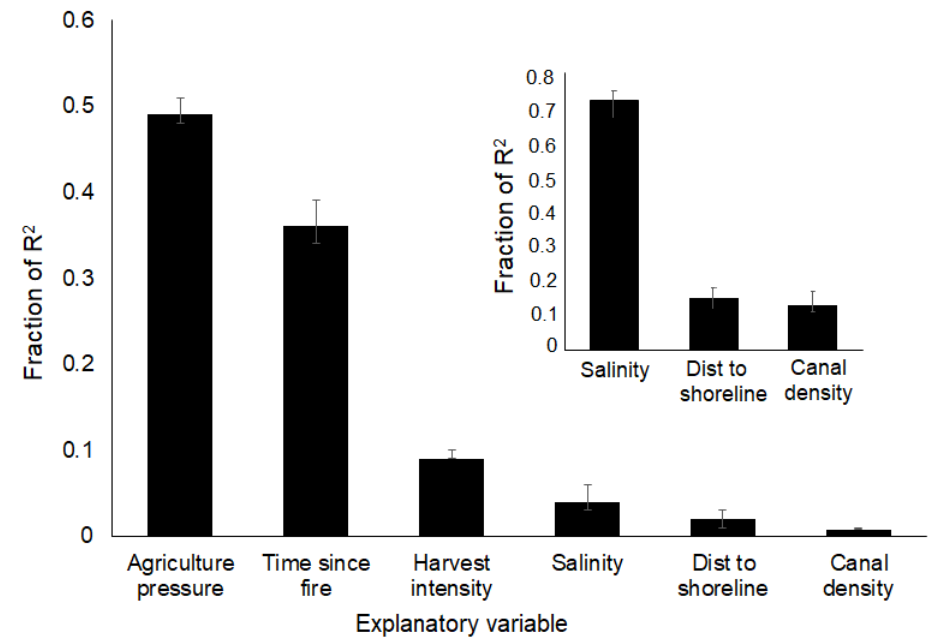
Figure 4. Relative importance for each predictor variable used in the final model (R 2 = 0.39) with 95% bootstrap confidence intervals using the method from [79]. Metrics are normalized to sum to 100%. Inset shows the relative importance of predictor variables for a model that includes only the sea level rise drivers (R 2 = 0.05).